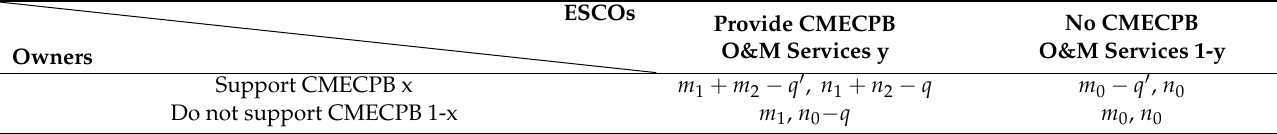
Table 2. Game payoff matrix for ESCOs and owners.